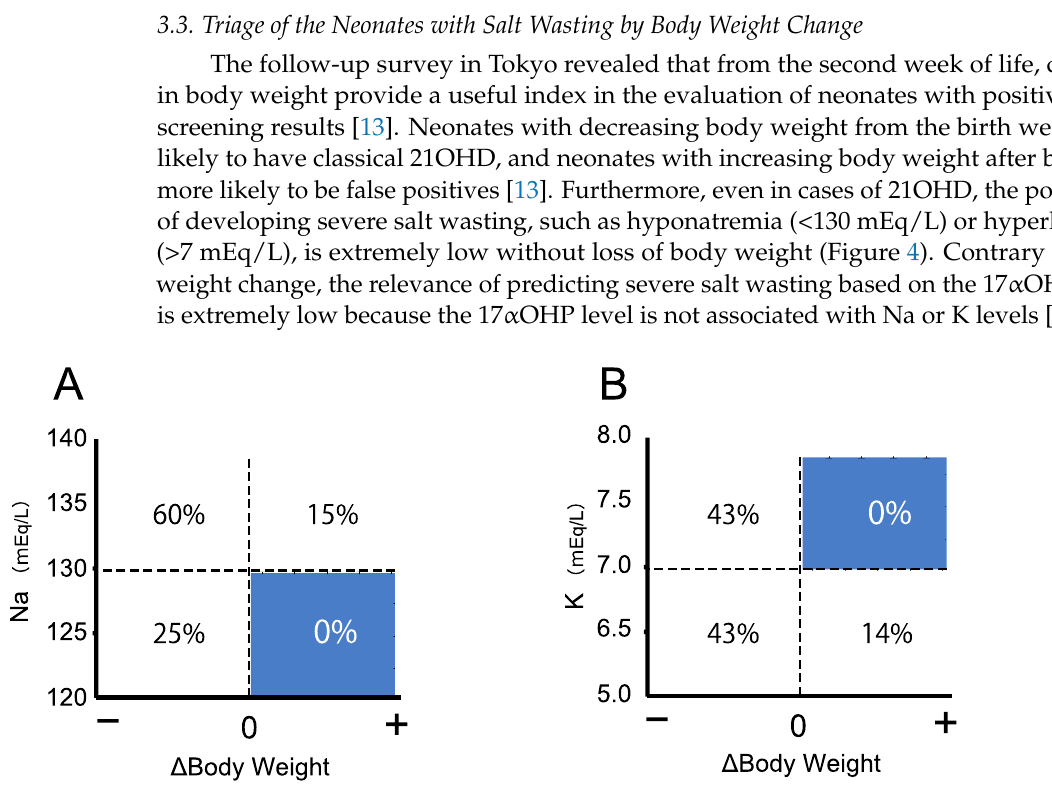
Figure 4. Body weight change from birth is an excellent predictor of 21OHD and the risk of severe salt wasting. Body weight data of 21OHD patients at 7–14 days after birth were collected, and the change in body weight from birth weight was examined. None of the 21OHD patients with severe salt wasting (Na < 130 meq/L or K > 7.0 mEq/L) exhibited increased body weight ( A , B ).